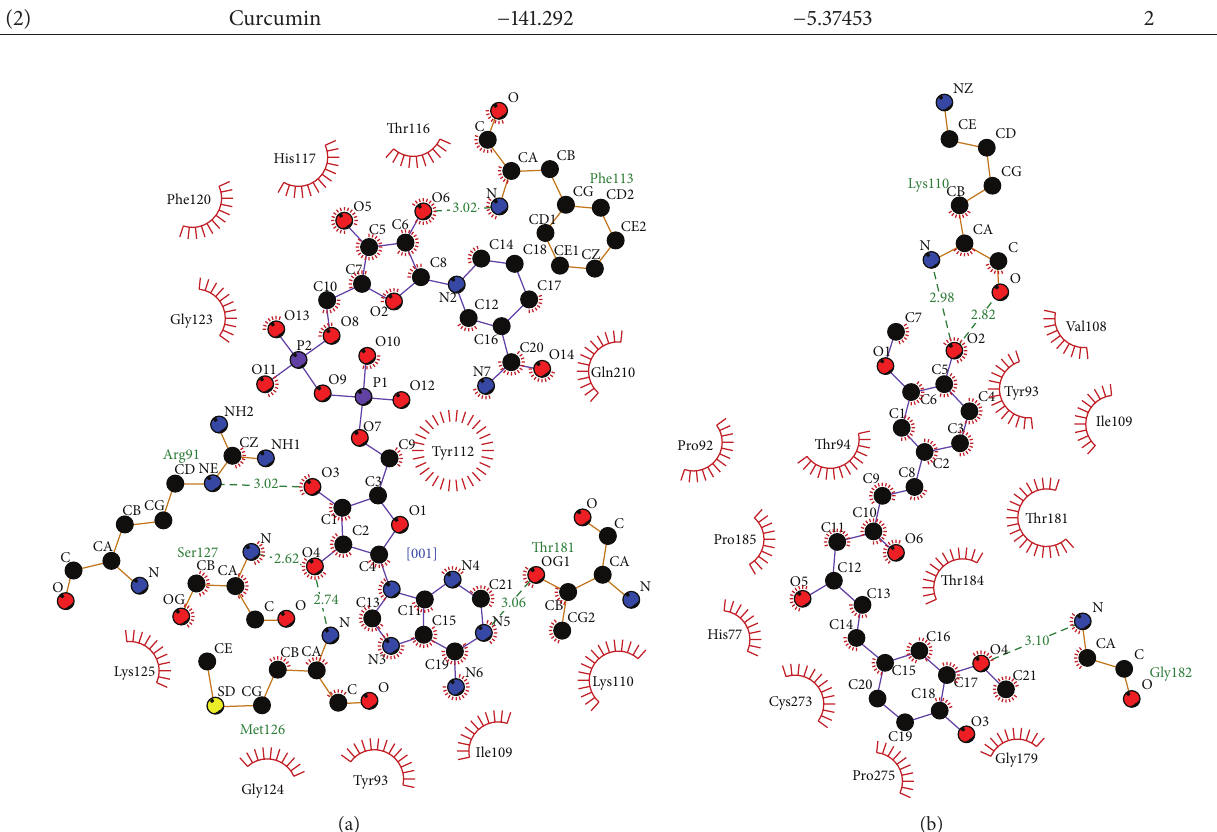
Table 2: Comparative docking simulation result of selected molecule and curcumin with human NADH-cytochrome 𝑏 5 reductase together with FAD, ligand from X-ray crystallized data of protein data bank (1umk.pdb) using Molegro Virtual Docker (MVD). S. number